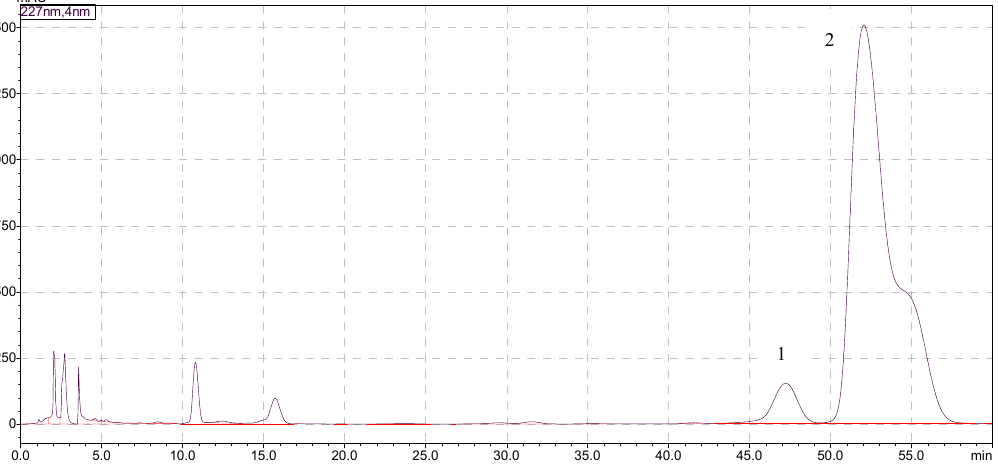
Figure 2. Chromatogram of the semi-preparative liquid phase with Aiglent ZORBAX SB C 18 , (250 × 4.6 mm, 5 µm), mobile phase: ACN (A), water (B), 0–60 min, 22% A; fl ow rate: 1.0 mL/min; detection: 227 nm.